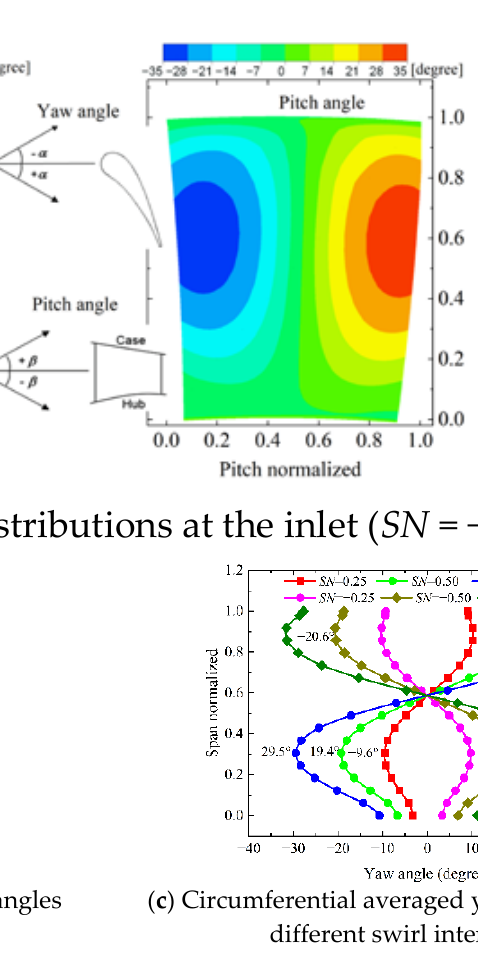
Figure 3. Hot streak at the inlet.